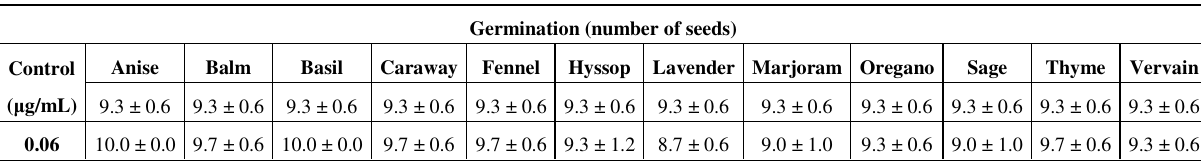
Table 3. Effects of different doses of essential oils on germination and radicle elongation of Lepidium sativum . The data are expressed as mean of three replicates ±